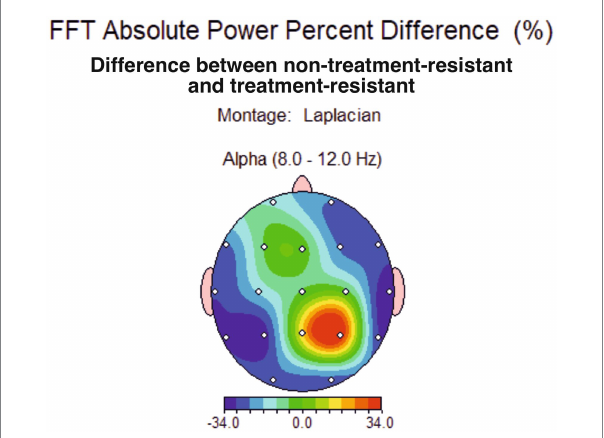
FIGURE 4 Topographical distribution of conventional alpha band average power percent difference between major depression group non- treatment-resistant (non-TRD) and treatment-resistant depression group (TRD), showing a 34% difference for the alpha band at P4 site.